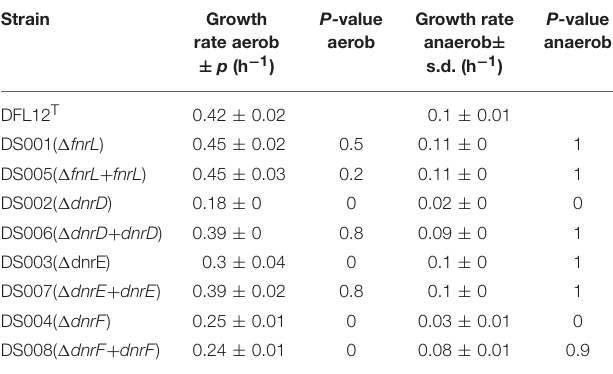
TABLE 3 | Growth rate of D. shibae DFL12 T wild type strain and corresponding mutant strains under aerobic and anaerobic growth